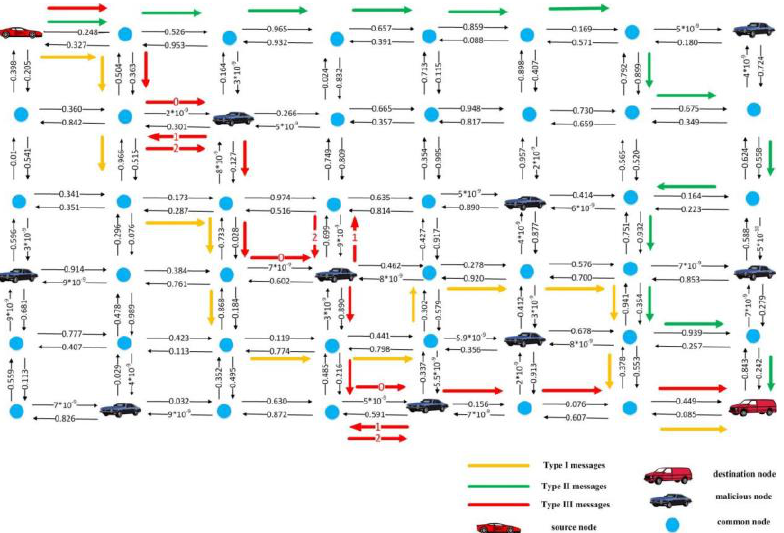
Figure 3. Schematic of the performance details of the proposed strategy for the three message types.